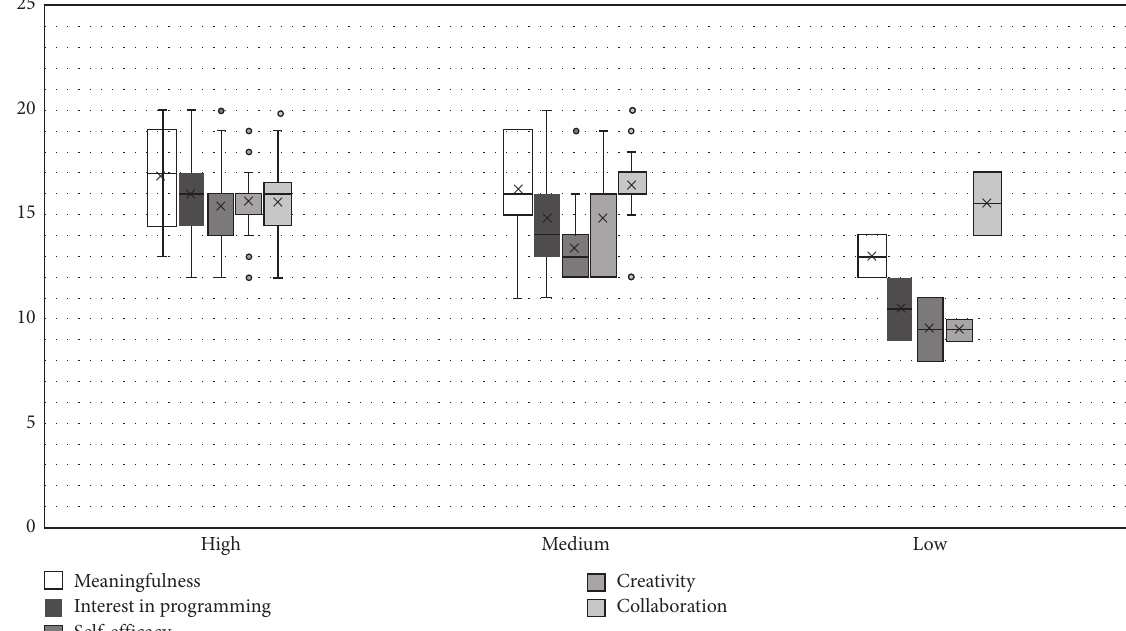
Figure 2: Box plots for total scores of attitudes in each dimension split by learning